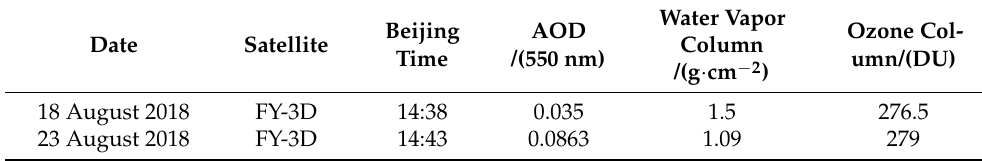
Table 2. Atmospheric parameters at the time of overpass.